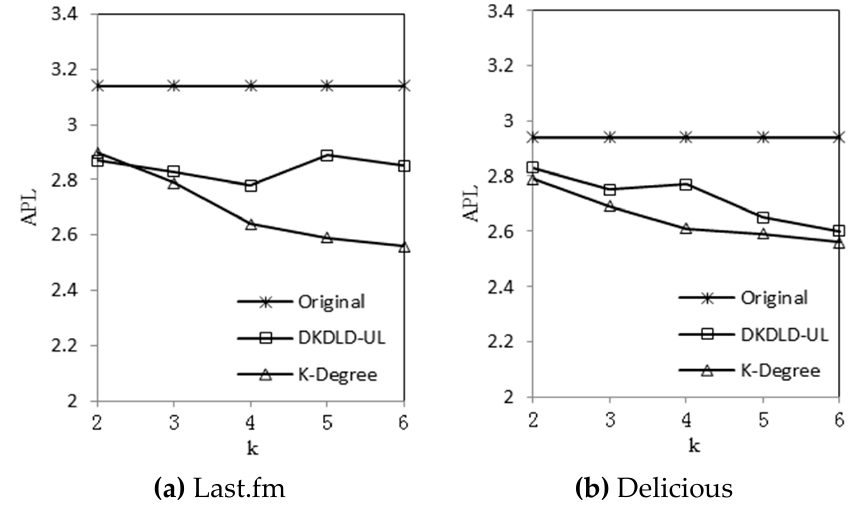
Figure 6. Last.fm dataset ( a ) and Delicious dataset ( b ): APL for different k values.